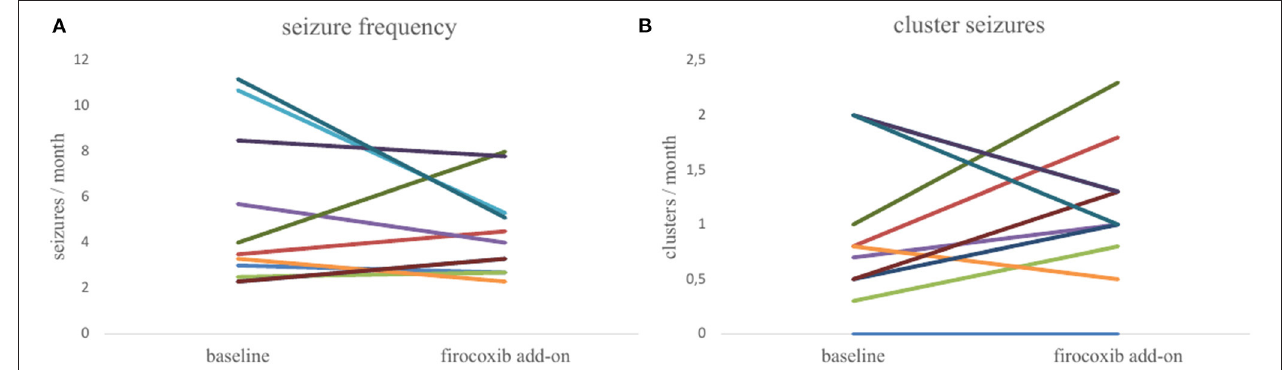
FIGURE 2 | Pairwise comparisons of the monthly seizure and cluster seizure frequency of the study population ( n = 11) before and during firocoxib add-on treatment. (A) Seizure frequency: The median seizure frequency for the study population at baseline and during firocoxib add-on treatment was 3.5 (range 2–11) and 4.0 (range 2–8), respectively. The median seizure frequency did not significantly differ between the baseline period and the firocoxib add-on treatment phase ( p = 0.59). Seizure frequency decreased considerably ( ≥ 50%) in two dogs with the highest seizure frequency. (B) Cluster seizure frequency: The median cluster seizure frequency at baseline and during firocoxib add-on treatment was 0.8 (range 0–2) and 1.0 (range 0–2), respectively. The cluster seizure frequency did not significantly differ between the baseline period and the firocoxib add-on treatment phase ( p = 0.57).